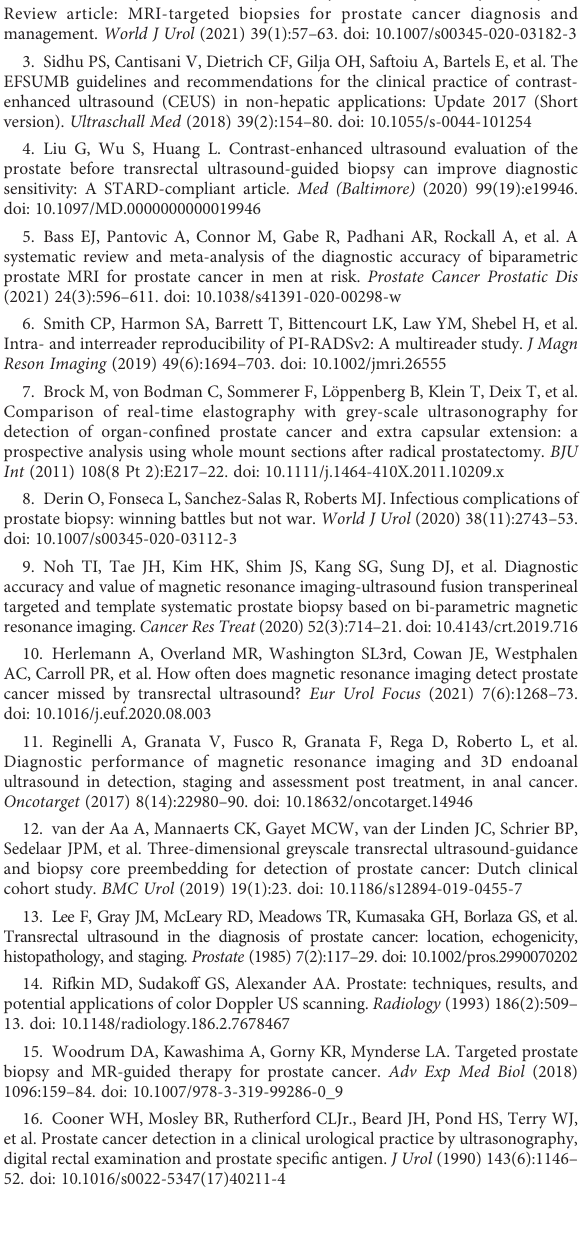
(C) Blood fl ow plethysmogram of benign prostatic hyperplasia in coronal section; (D) Blood fl ow chart of benign prostatic hyperplasia in cross section; (E) Blood fl ow chart of benign prostatic hyperplasia in longitudinal section; (F) Blood fl ow chart of benign prostatic hyperplasia in coronal